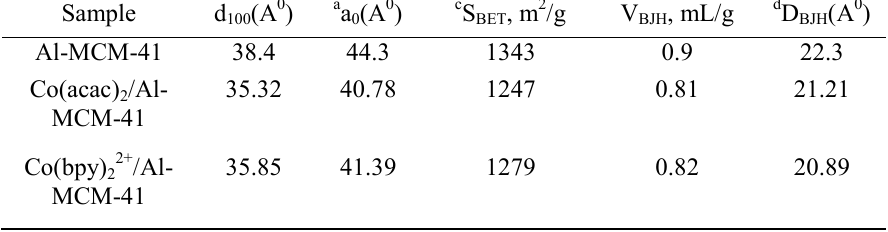
Table 1. Texture parameters samples taken from XRD and nitrogen adsorption studies.